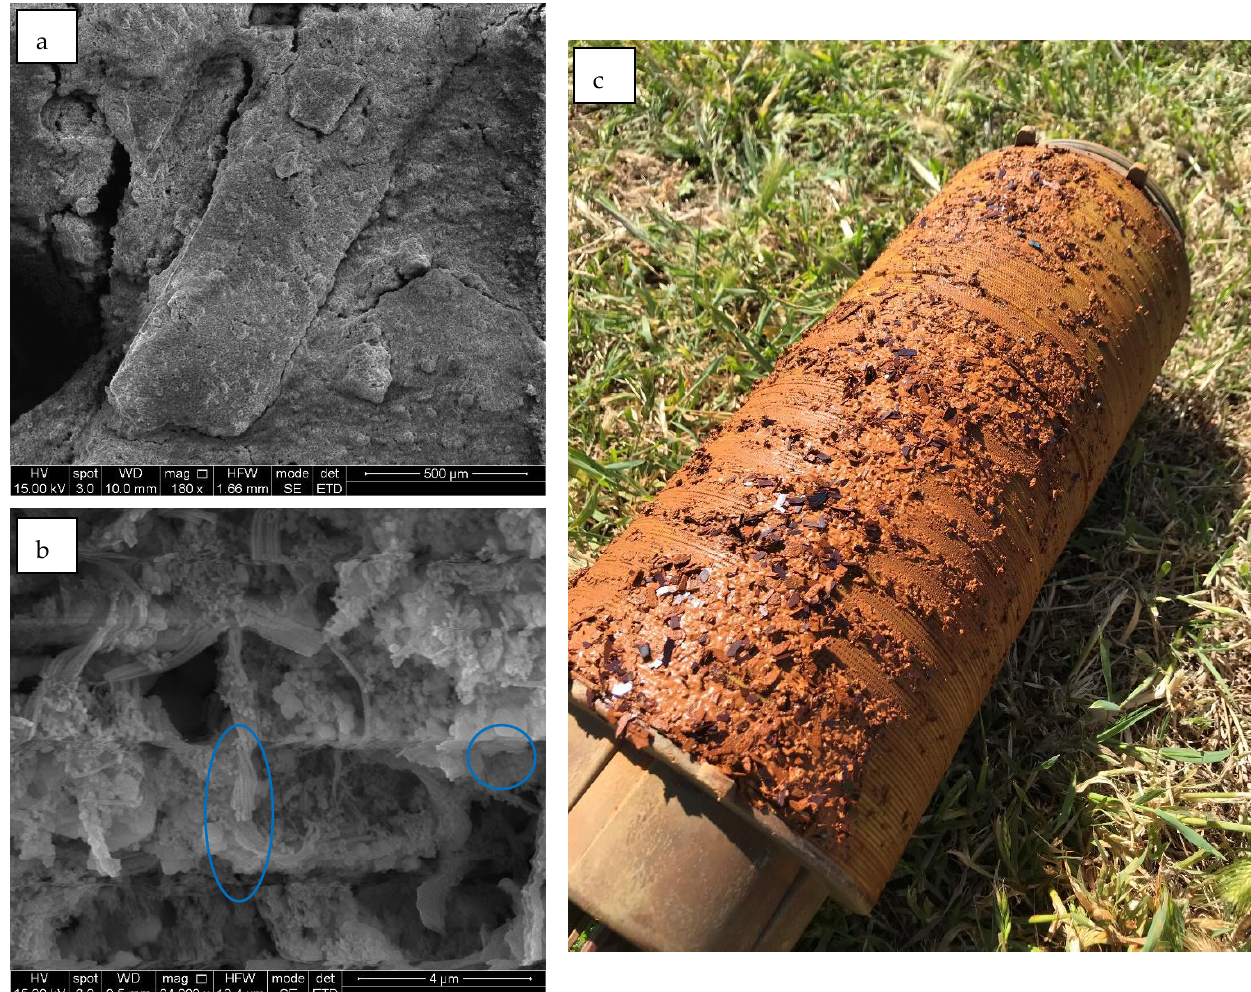
Figure 8. SEM of clogging material: ( a ): crystalline structure suggesting amorpheous iron oxides; ( b ): blue circles show the evidence of biological structure suggesting microbial growth; ( c ): incrustations of a clogged screen, which was sampled for SEM analysis.